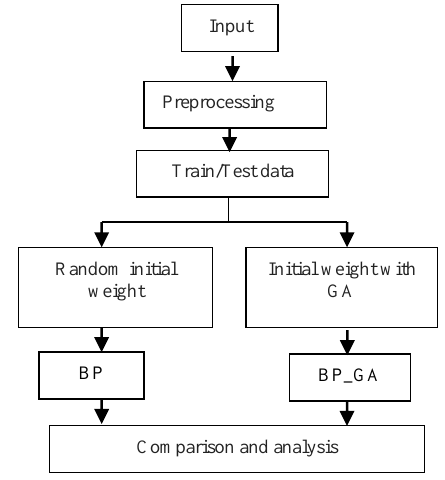
Figure 3. Research methodology.